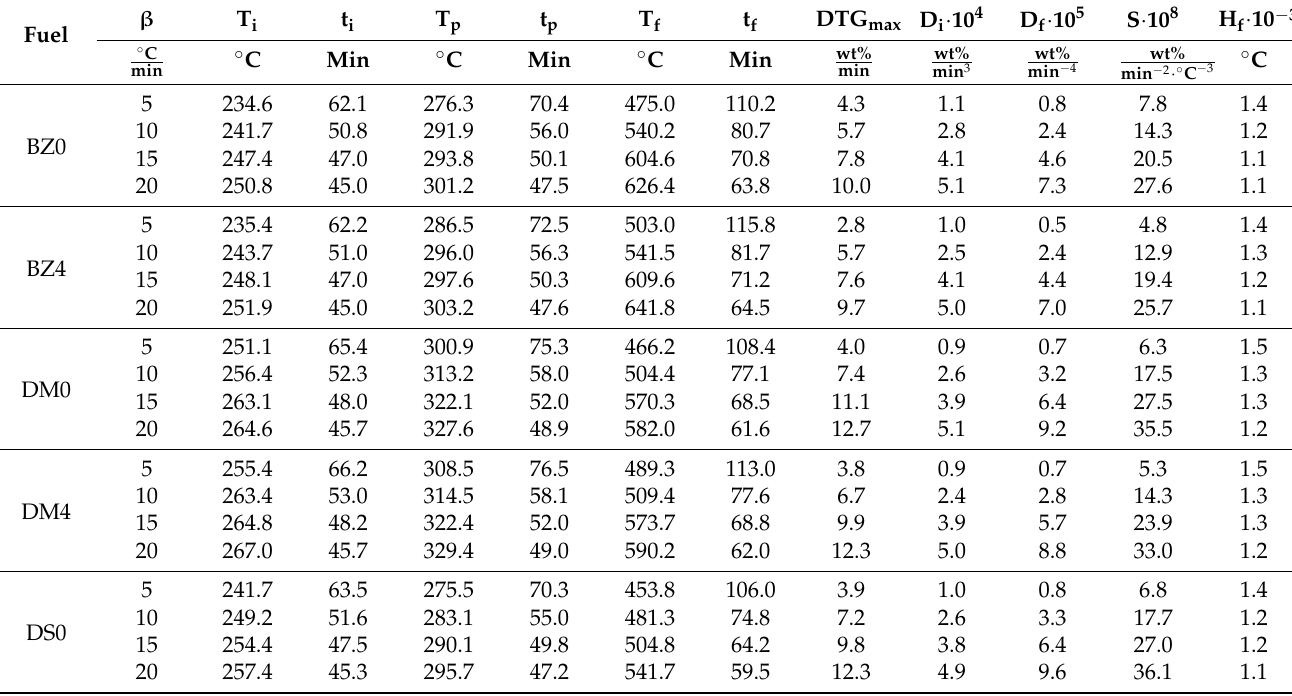
Table 3. Main combustion